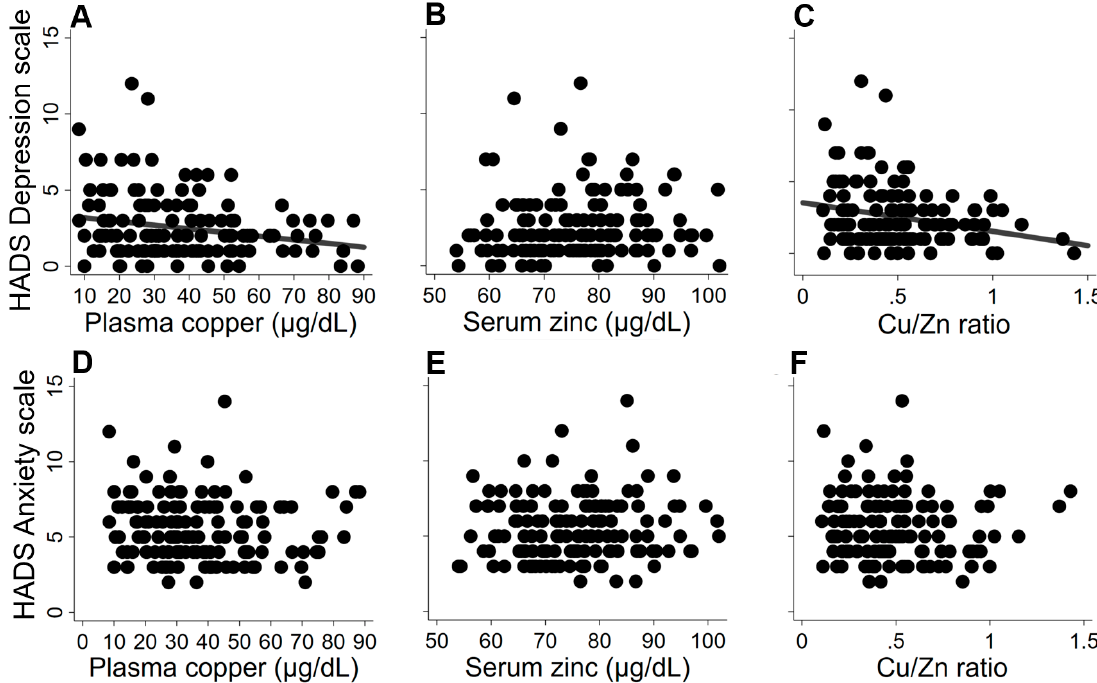
Figure 2. Association between HADS Depression scale ( A )–( C ) and HADS Anxiety scale ( D )–( F ) with ( A , D ), zinc (adjusted for IL-6) ( B , E ) and Cu/Zn ratio ( C , F ). Results were adjusted for age, sex, BMI, habitual physical activity (kJ weekly spent in vigorous activity), genotypes for APOE (carriers of ɛ 4 / non-carriers), education (primary school / high school / technical certificate / university), and history of CVD (yes / no). HADS, Hospital Anxiety and Depression Scale. Multiple linear regression analysis also revealed a modest positive association between plasma copper concentrations and BDNF, while serum zinc and Cu/Zn ratio were not associated with any of